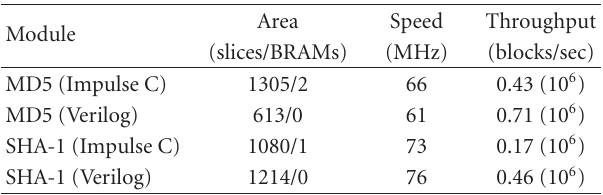
Table 5: Cryptographic module performance benchmarks in an